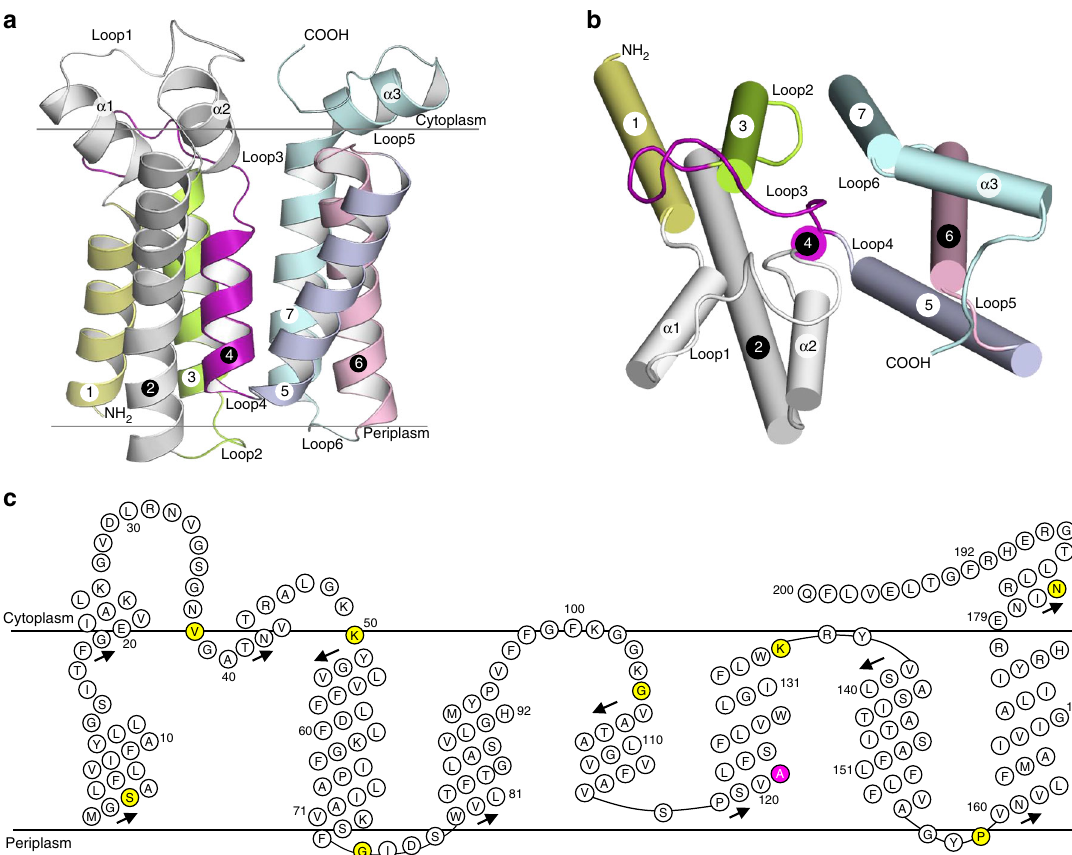
Fig. 2 Crystal structure and membrane topology of aa PlsY. a View from the membrane plane. The membrane boundary was de fi ned by the OPM server 68 . TMHs and loops are appropriately labeled. b View from the cytoplasm. c Membrane topology of aa PlsY. Residues with consistent topological assignment between the previous report 12 and our structure are highlighted in yellow; the single outlier (Ala121) is highlighted in magenta. Arrows mark helix directions from N to C